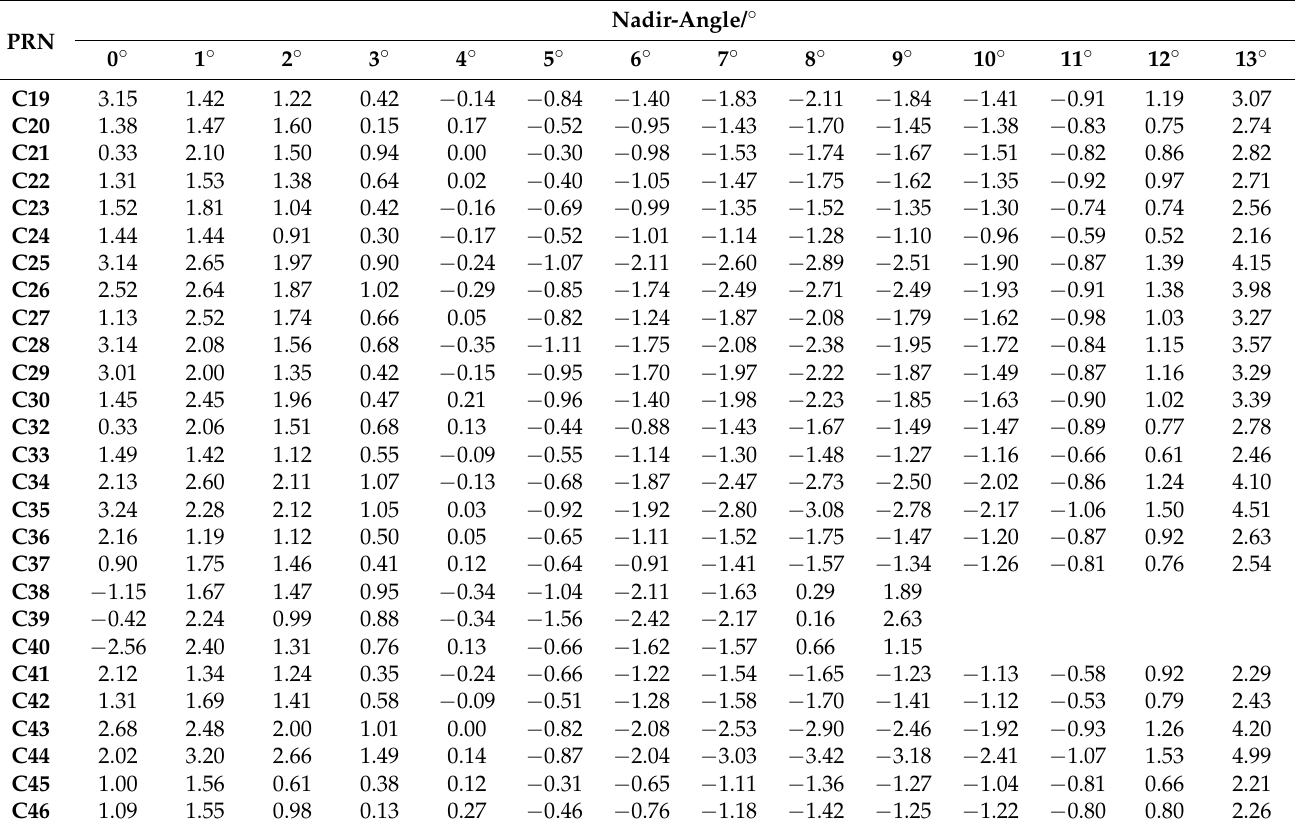
Table 5. Final PCVs for each satellite of the 2-Step Scheme, the unit is